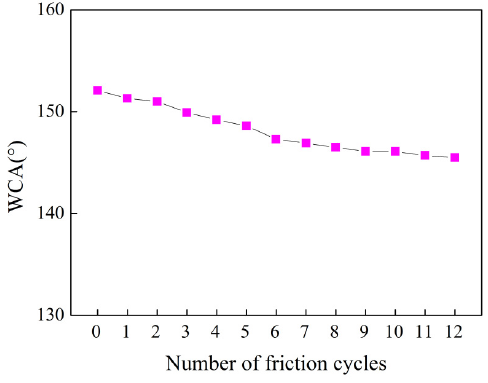
Figure 9. Abrasion resistance coating test surface CAs.